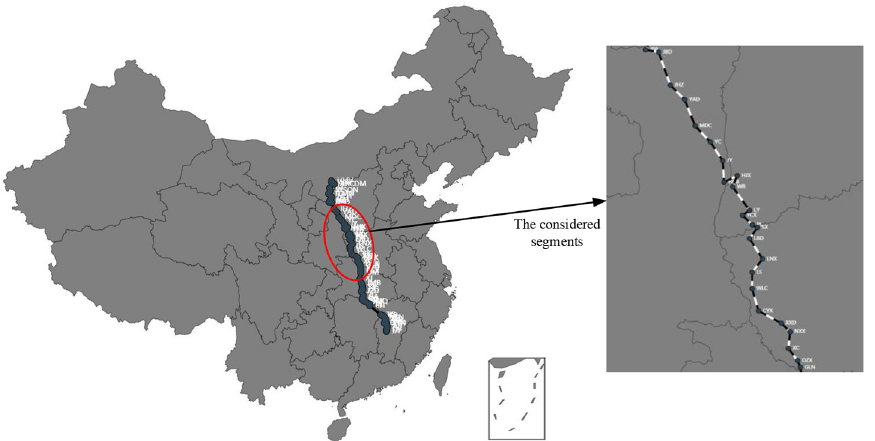
Figure 4. Haolebaoji-Ji ’ an railway line in